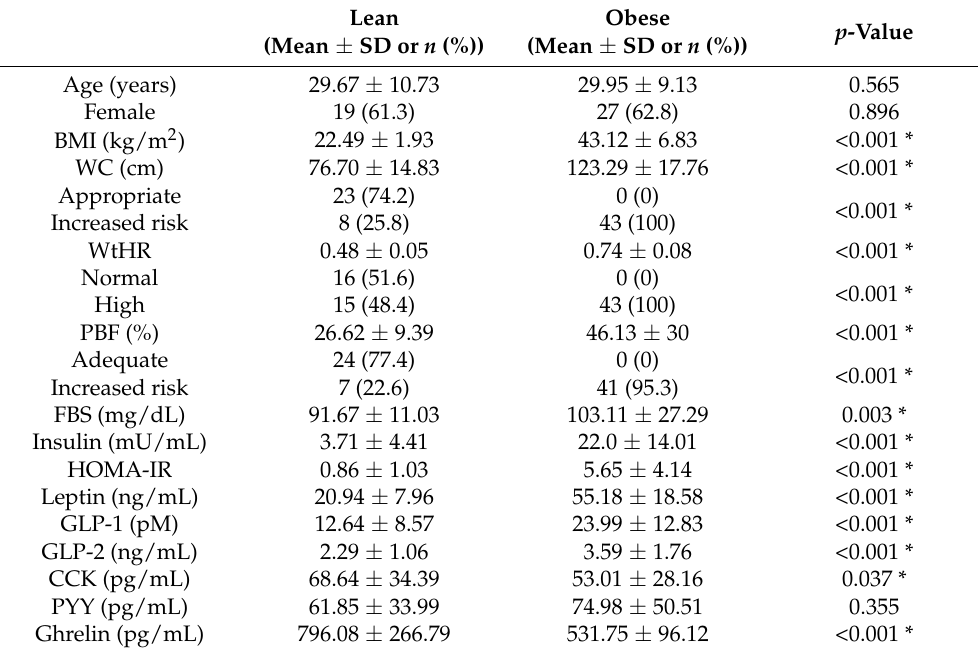
Table 1. Comparison of demographic, anthropometric, and biochemical parameters between lean and obese participants.